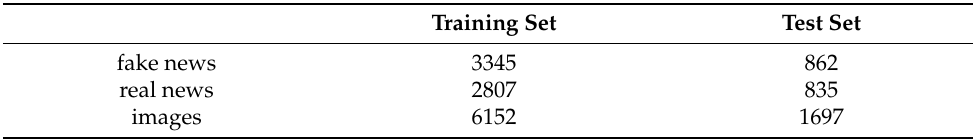
Table 1. The Weibo